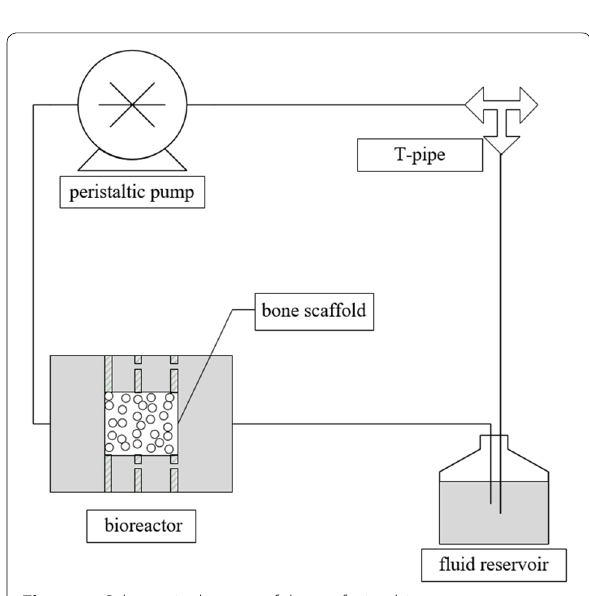
Figure 5 Schematic diagram of the perfusion bioreactor